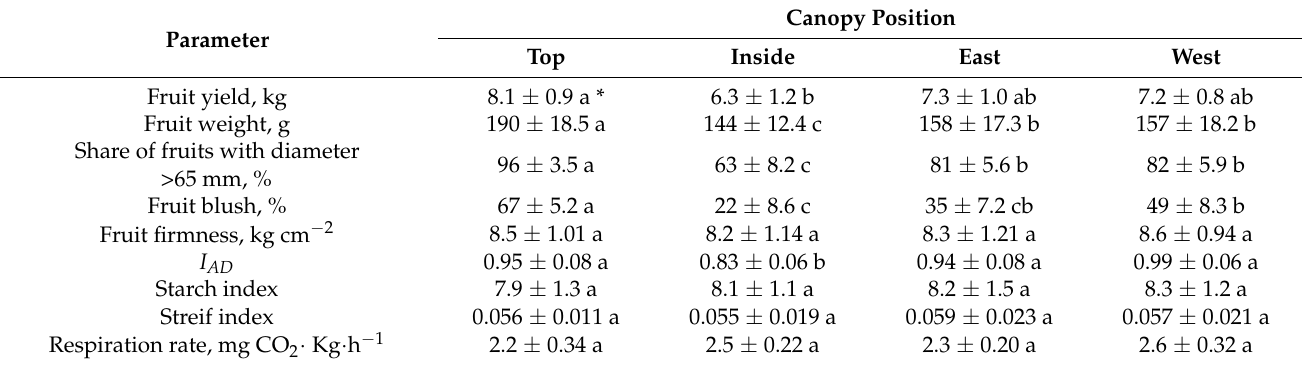
Table 2. Effect of canopy position on yield, fruit quality and maturity indices, average